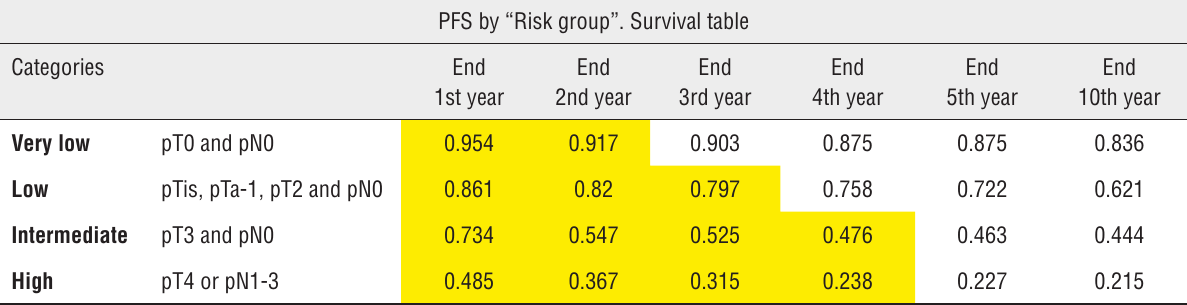
Table 6 - Survival table (PFS) by "Risk group".